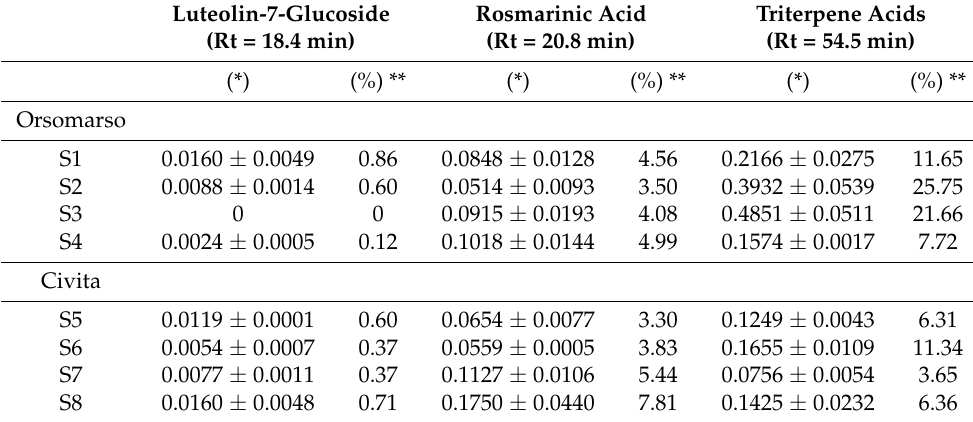
Table 4. Luteolin- 7 -glucoside, rosmarinic acid, and triterpenic acids quantification in sage extracts